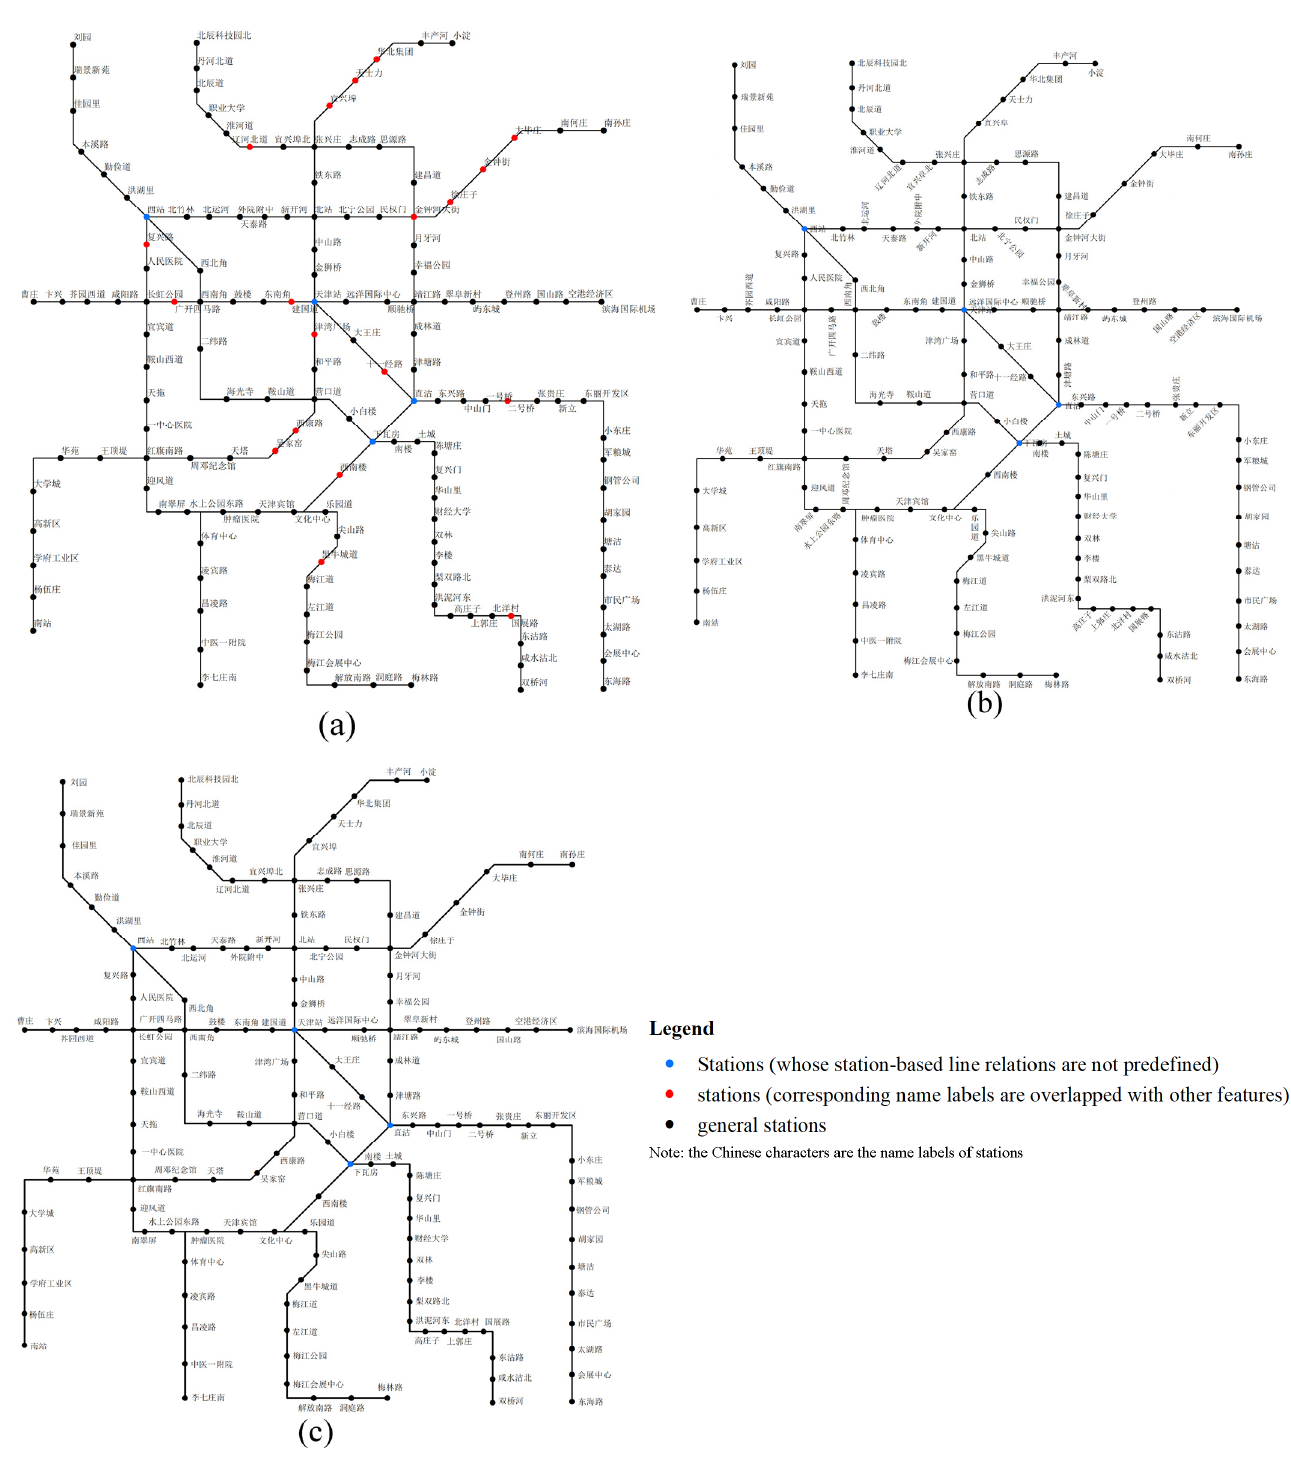
Figure 12. Name labels of Tianjin metro networks placed by: ( a ) maplex; ( b ) descriptive-statistics- based method; and ( c ) ANNs.